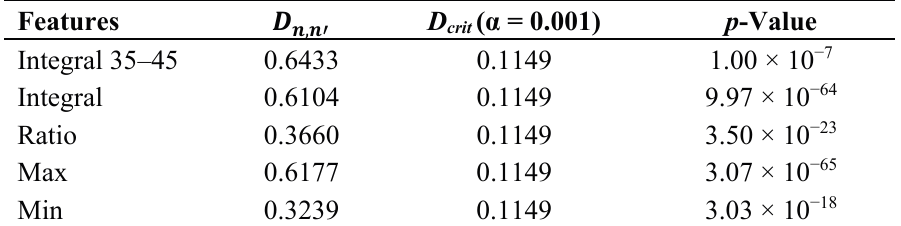
Table 5. Kolmogorov-Smirnov tests for C3 and C4 classification